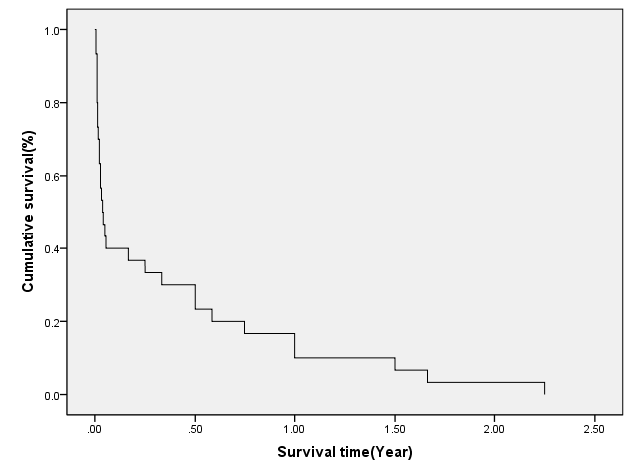
Fig. 2 - Survival rates of the operated